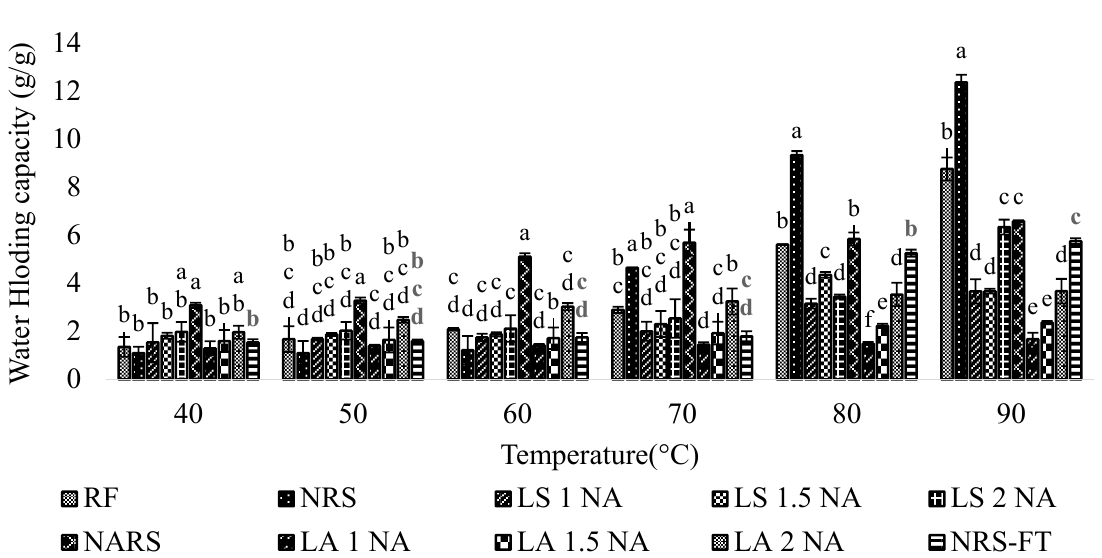
Figure 3. Water holding capacity of the RD 31 rice flour, native starches, and modified starches at different temperatures. Di ff erent su ffi x (a–f) within same temperature indicate significant di ff erences